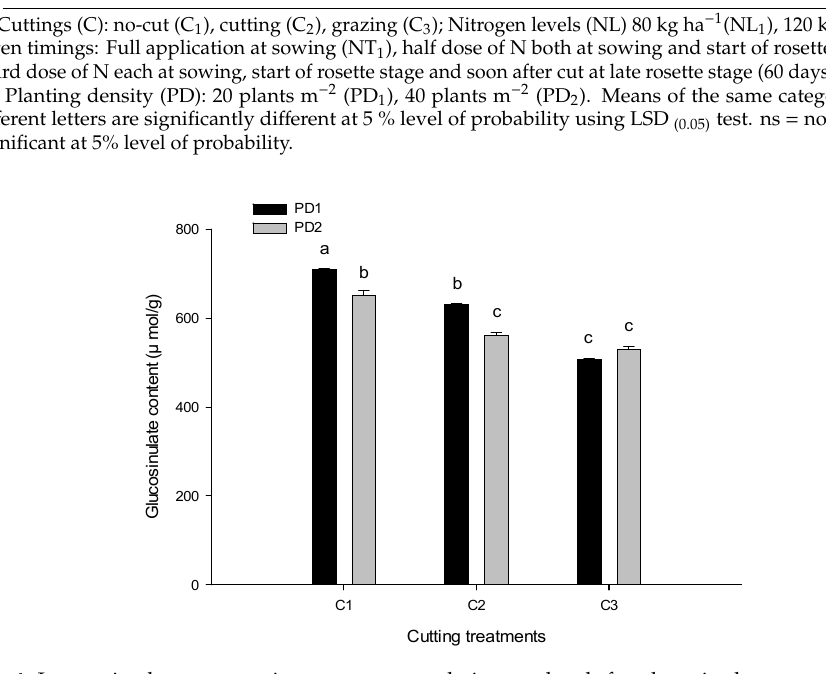
Figure 4. Interaction between cutting treatments and nitrogen levels for glucosinulates content. Vertical bars represent Standard Error. Note: Cuttings (C): no-cut (C 1 ), cutting (C 2 ), grazing (C 3 ); Planting density (PD): 20 plants m − 2 (PD 1 ), 40 plants m − 2 (PD 2 Table 8. Canola glucosinolates content ( μ mol g − 1 ) as affected by cutting treatments, nitrogen levels and application timings under varying planting densities.